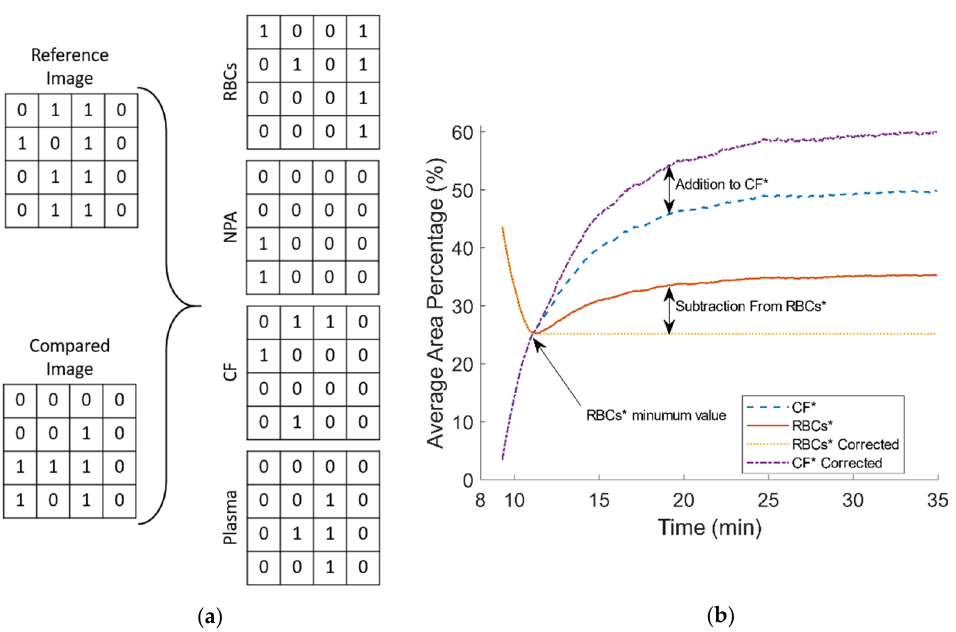
Figure 2. ( a ) Representative binary comparison between parts of a reference and a subsequent image, and the resulted output matrices. ( b ) The behavior of 𝑅𝐵𝐶𝑠 ∗ and 𝐶𝐹 ∗ after clotting start (CS) and the correction process.